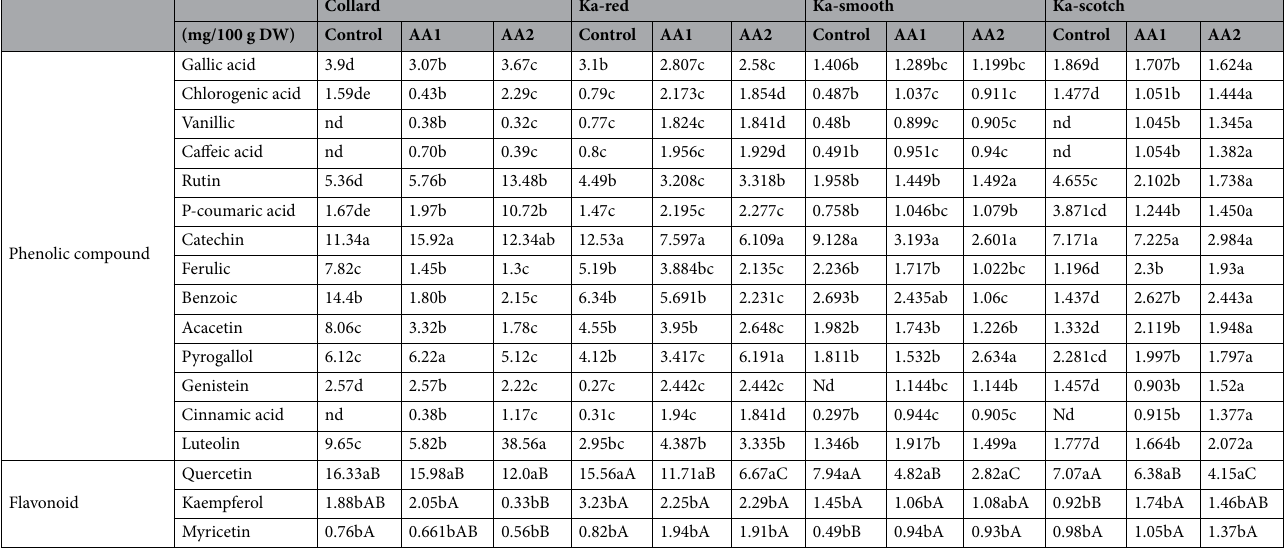
Table 6. Interaction effect of cabbage cultivar and AA application on phenolic acids and flavonoid parameters. Nd not detected, Control control treatment, AA1 150 mg/L of amino acid, AA2 150 and 300 mg/L of amino acid. According to the least significant difference test, a column in each treatment and means followed by the same letter is not significantly different at P < 0.05. Upper letter showed significant effect of AA application on flavonoid in each row.